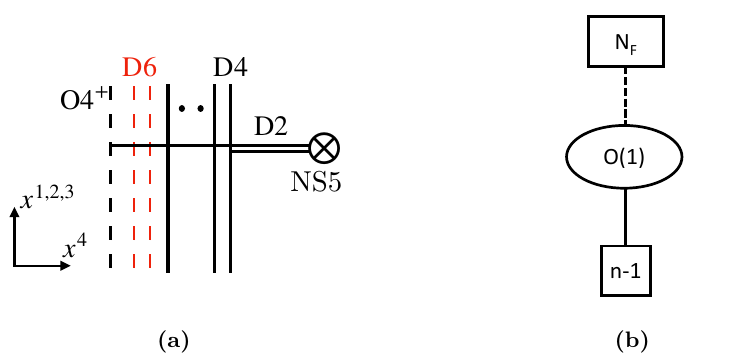
Figure 30. (a). The brane configuration that describes the monopole screening sector v = e N and the contribution Z 0 ( a ) in h T i . (b). The corresponding quiver diagram. ∧ 2 V mono ,N